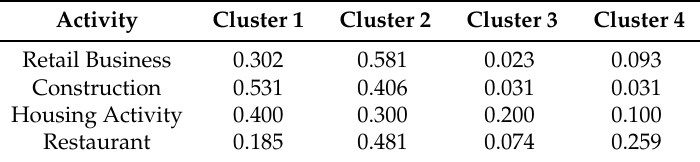
Table 3. Correlation matrix: Activity vs Cluster